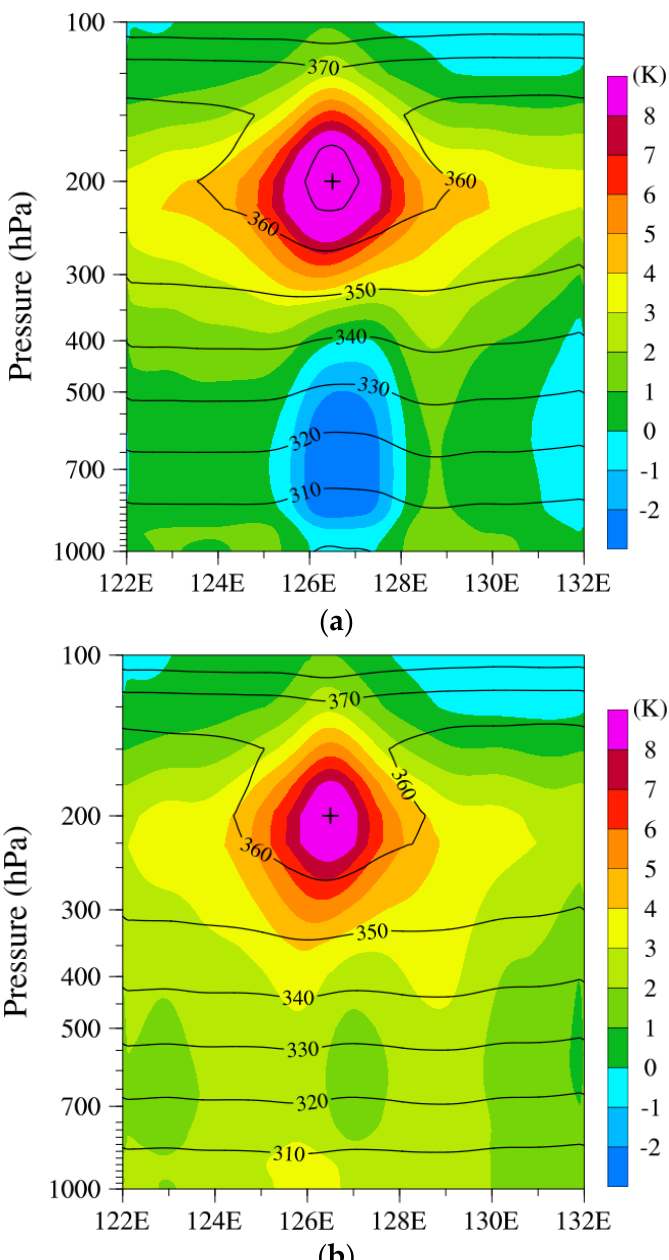
Figure 7. Spatial distribution of ( a ) MWTS-2 brightness temperature observations at channel 6 and ( b ) 250 hPa retrieved temperatures at the FY-3D descending node within and around Typhoons Lekima located at (126.5° E, 22.1° N) at 1724 UTC and Krosa located at (140.2° E, 22.4° N) at 1545 UTC on 7 August 2019.